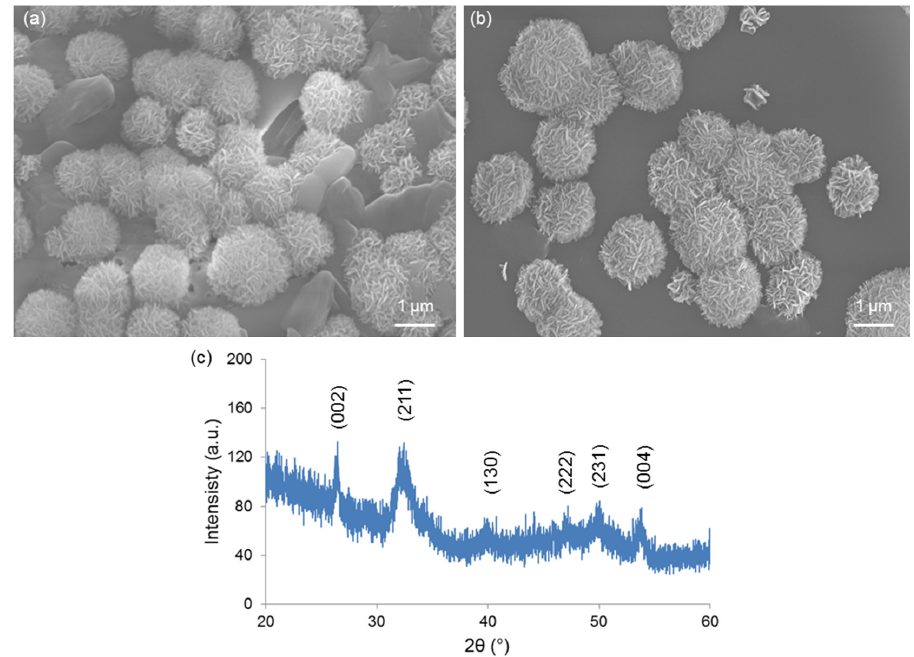
Figure 6. In vitro bioactivity tests: SEM micrographs showing the “cauliflower” calcium-phosphate agglomerates formed on ( a ) 1Cu-glass and ( b ) 5Cu-glass after immersion for 2 weeks in SBF; ( c ) XRD analysis on 5Cu-glass (2 weeks in SBF), which reveals the diffraction peaks of hydroxyapatite formed during the test.